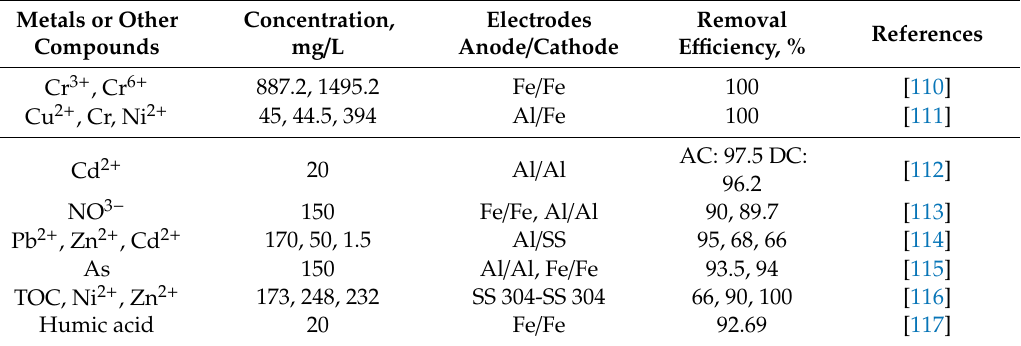
Table 6. Removal e ffi ciency of heavy metal ions for di ff erent anode / cathode electrode combination in electrocoagulation system.